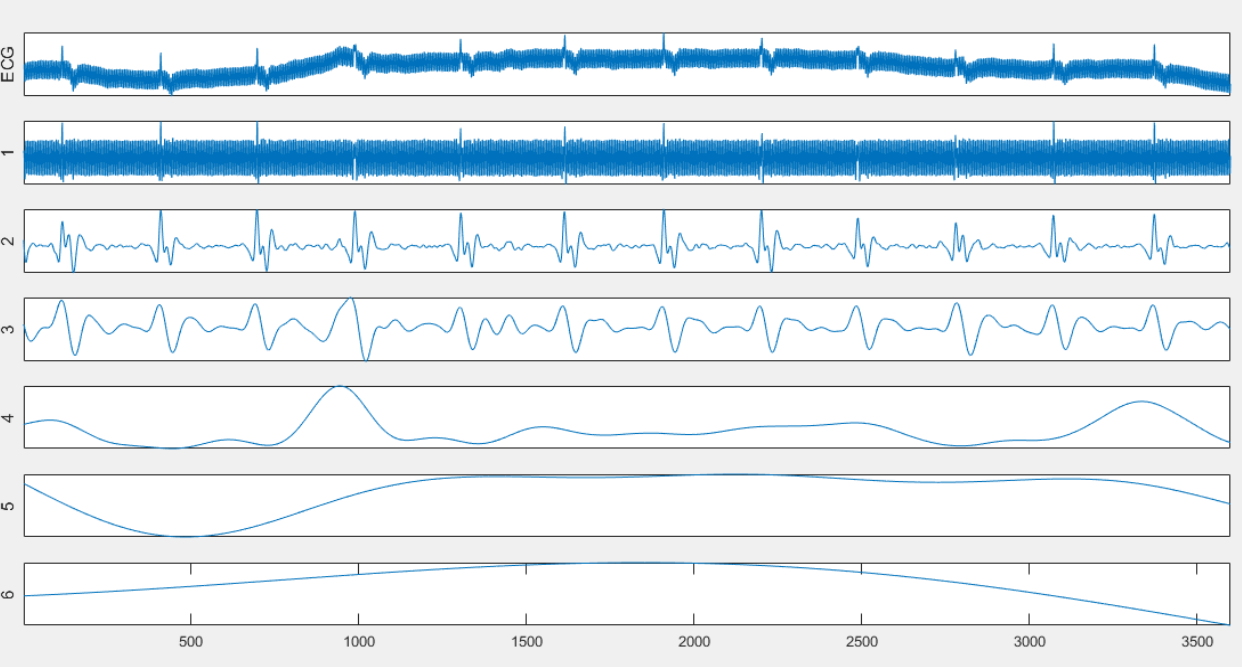
Figure 1. Intrinsic mode functions of a noisy ECG signal using iterative filtering.